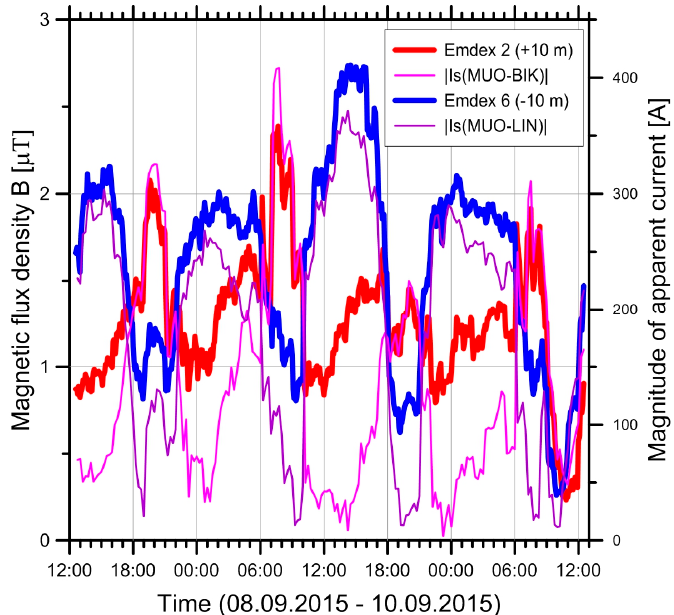
Figure 11. Magnitude of apparent current in the two circuits MUO ‐ BIK and MUO ‐ LIN and magnetic fields measured at ± 10 m (Emdex 2 and Emdex 6, measurement M9 in Iffwil). Emdex 2 measures on the side of MUO ‐ BIK, Emdex 6 on the side of MUO ‐ LIN.